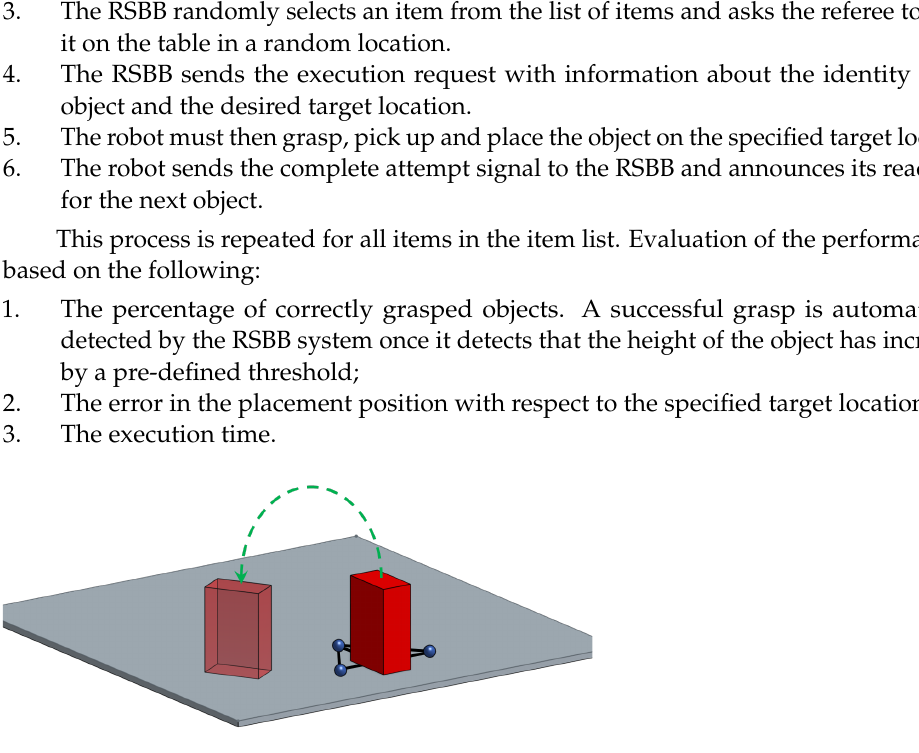
Figure 12. Illustration of the Pick and Placing benchmark with the objective of grasping, picking and placing the object on a specified target position. MoCap markers attached under the object allow the MoCap system to continuously measure the true object